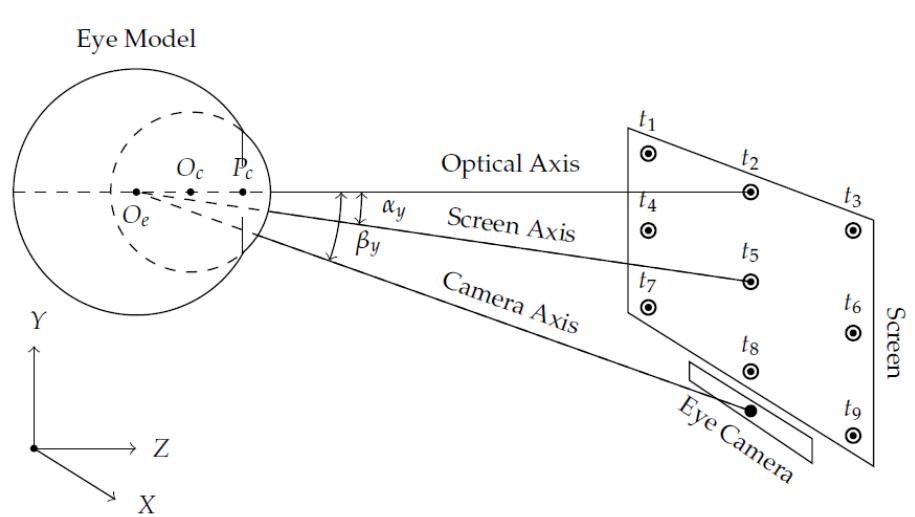
Figure 1. This geometric relationship shows schematic representations of the eye, eye-camera, and screen in a remote setup. Gullstrand–Le Grand Eye Model represents a simplified mathematical model for the human eye as (i) a set of two spheres with distinct size to describe the eyeball, and corneal surface; (ii) the rotation of the eye around a fixed point ( O e ); and (iii) the optical axis that passes through the eyeball center ( O e ), cornea center ( O c ), and pupil center ( P c ), and coincides with the calibration target t 2 . The line that joins the eyeball center and the center of the screen corresponds to the screen axis. The eye-camera is under the screen and aligned horizontally with the center of the screen, and its axis joins the eyeball center and the camera